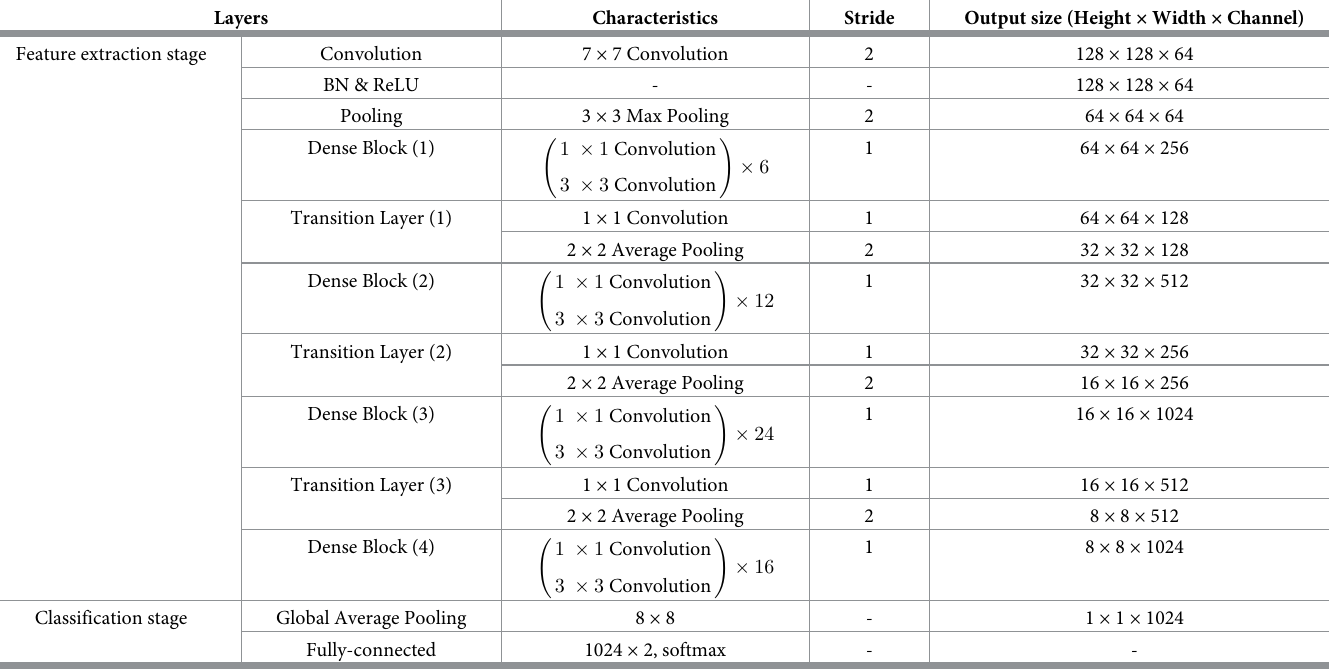
Table 2. Structure and characteristics of DenseNet121 based convolutional neural network classifier for panoramic radiography.